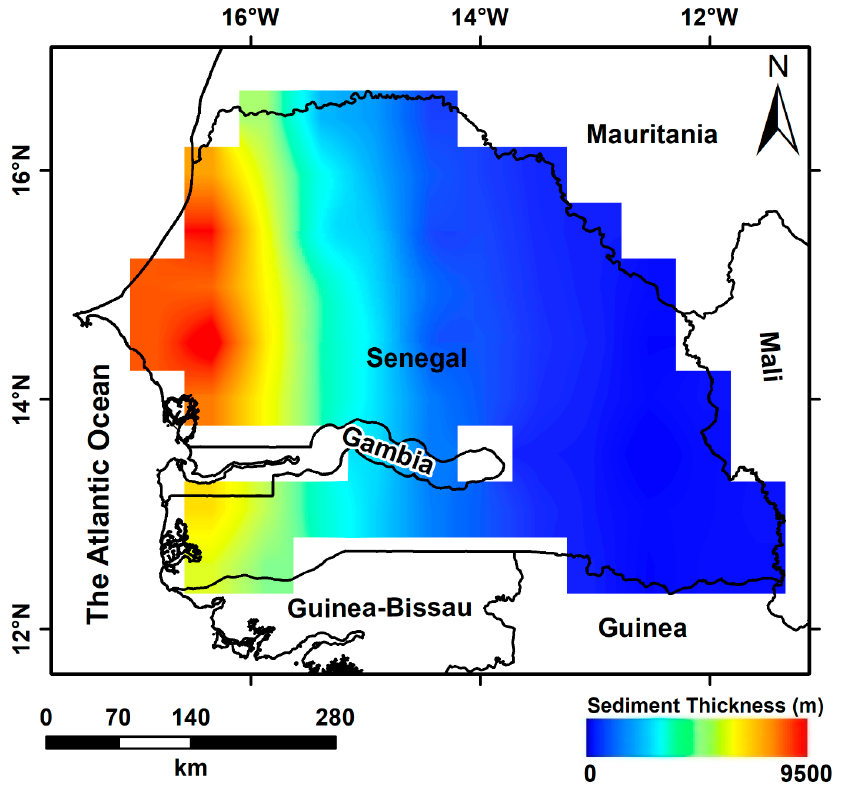
Figure 11. An illustration of the thickness of the sedimentary succession (m). By combining the Δ GWS variation rate +0.63 ± 0.08 cm/yr (+1.24 ± 0.16 km 3 /yr) and the artificial withdrawal rate (1.13 ± 0.11 cm/yr (2.22 ± 0.22 km 3 /yr; FAO, 2022) during the research period, the country is receiving an average recharge rate of 1.76 ± 0.14 cm/yr (+3.46 ± 0.27 km 3 /yr), we have added a 10% error for the artificial withdrawal rate. On the other hand, large hydrogeological environments, such as aquifer systems, have been eval- uated for their recharge and depletion rates using physical, chemical, and modelling methodologies [89–92]. However, regional implementation of these methods is challeng- ing because of a lack of requisite datasets, the time and effort required to obtain these data, and the sometimes-questionable quality of the conclusions they produce. The country needs to manage surface and groundwater resources to protect its groundwater resources. Water diversion and groundwater protection must be regulated by law. The installation of small dams in the major streams helps to prevent surface water from entering the ocean and feeds the groundwater supply of groundwater aquifers. 6. Conclusions GRACE offers an innovative approach to estimate the changes in terrestrial water storage on the territory of Senegal.